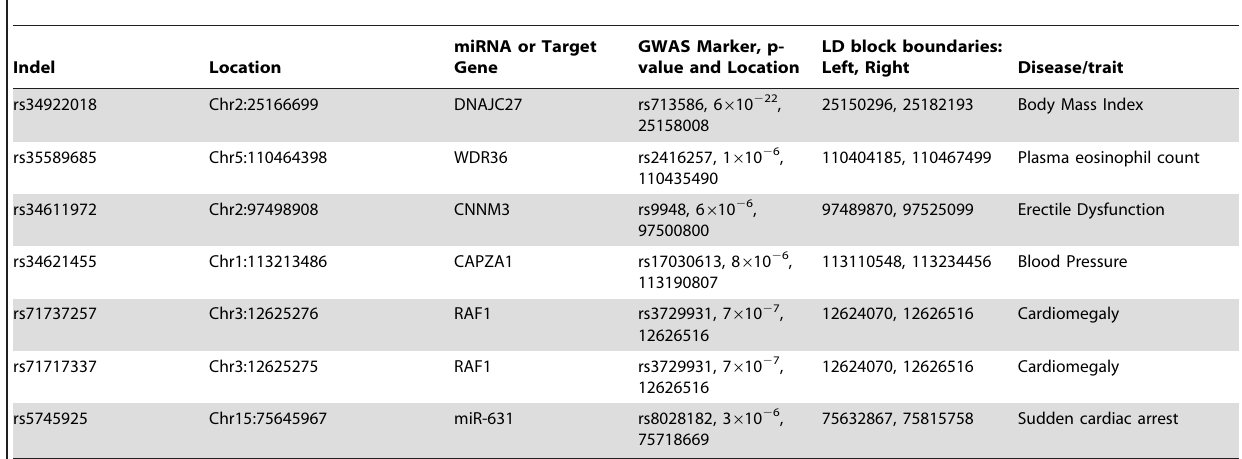
Table 2. Indels in miRNAs and miRNA target sites in linkage disequilibrium block for high-scoring markers from association studies.